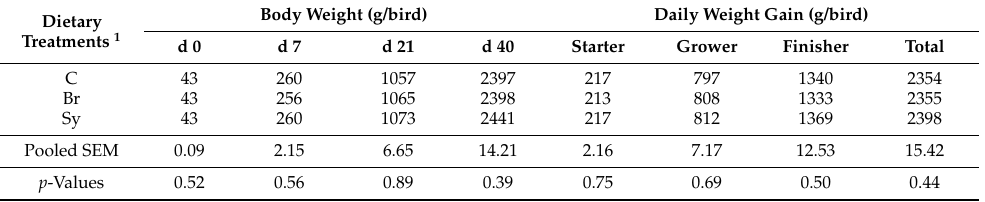
Table 1. Effect of dietary treatments on the body weight and daily weight gain of broiler chickens. Dietary Treatments 1